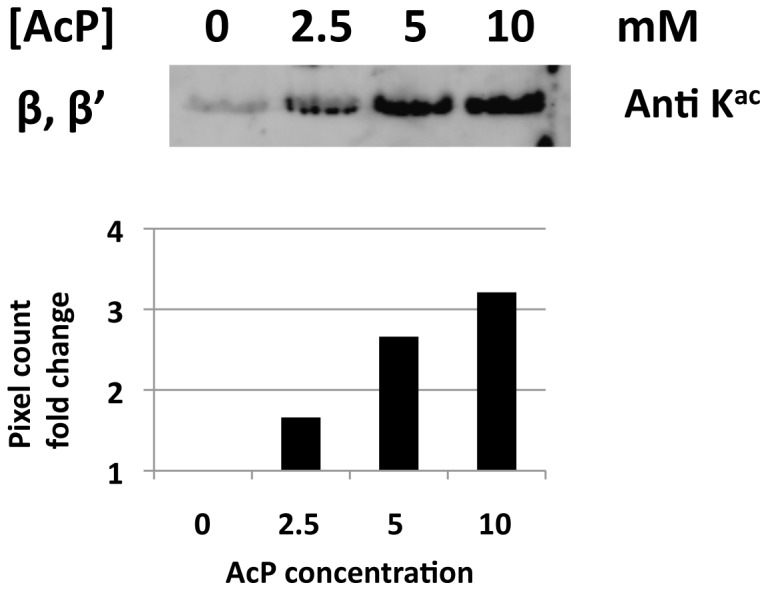

In vitro acetylation of RNAP with AcP.Purified RNAP σ70 holoenzyme was incubated with increasing concentration of acP for 1 hour at 30°C. After incubation, proteins were resolved by SDS-PAGE and transferred to a PVDF membrane. Protein acetylation was detected using a cocktail of two polyclonal anti-acetyllysine antibodies was used (Cell Signaling Technology) at a 1∶200 dilution and (ImmuneChem) at a 1∶500 dilution. Acetylation signals were quantified using AlphaView and normalized to the signal in the absence of acP.